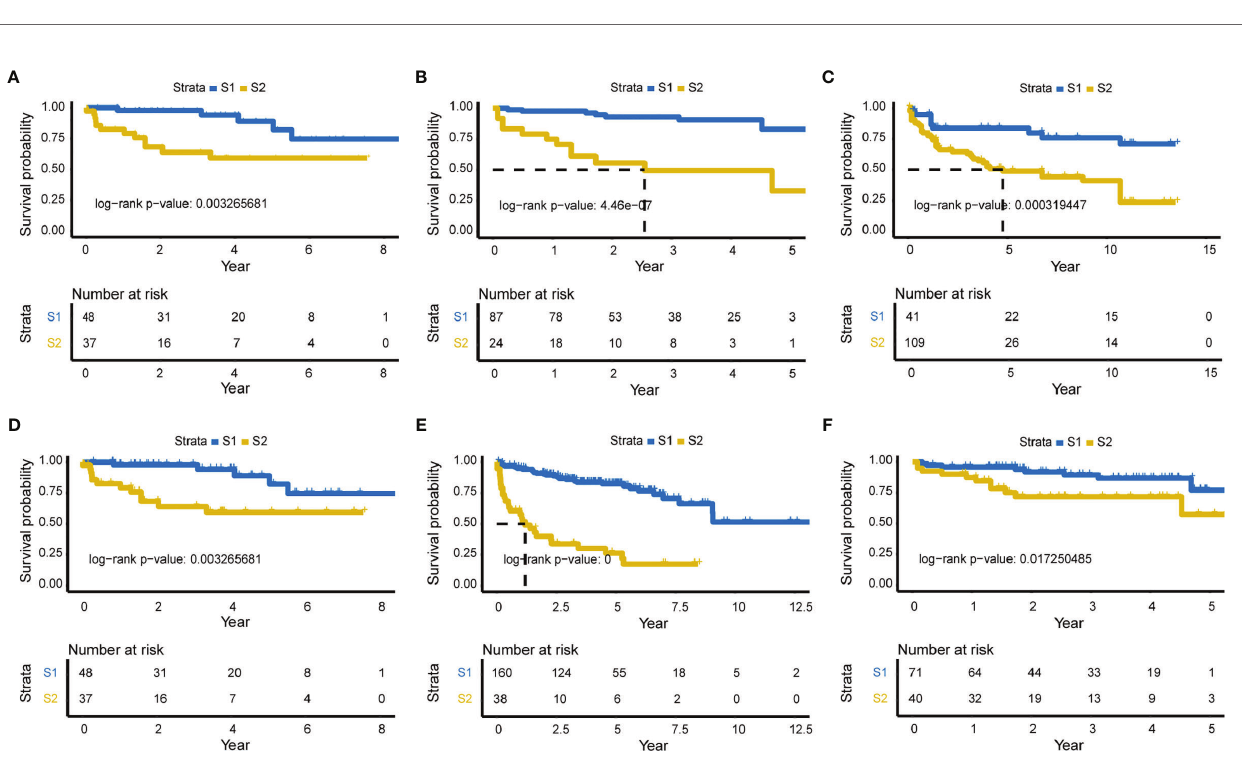
FIGURE 2 | Signi fi cant survival differences for model _3 and fi ve external validation sets. Relapse-related deep-features of model_3 were used for subgrouping, and KM plot was used to show the difference in relapse levels between the two subgroups. The Lasso model constructed according to model_3 was validated in each of the fi ve external validation sets. (A) KM plot of model_3 (log-rank P -value = 6e-09, the time of half relapse is about 3.5 years). (B) GSE70768 validation set (mRNA, Number of samples = 111, log-rank p -value = 4.46e-07). (C) GSE26367 validation set (miRNA, N = 149, log-rank P -value = 0.000319447). (D) GSE26126 validation set (DNA methylation, N = 85, log-rank P -value = 0.003265681). (E) GSE21035 validation set (CNVs, N = 198, log-rank P -value = 0), and (F) Re-annotated GSE70768 validation set (mRNA, N = 111, log-rank P -value =